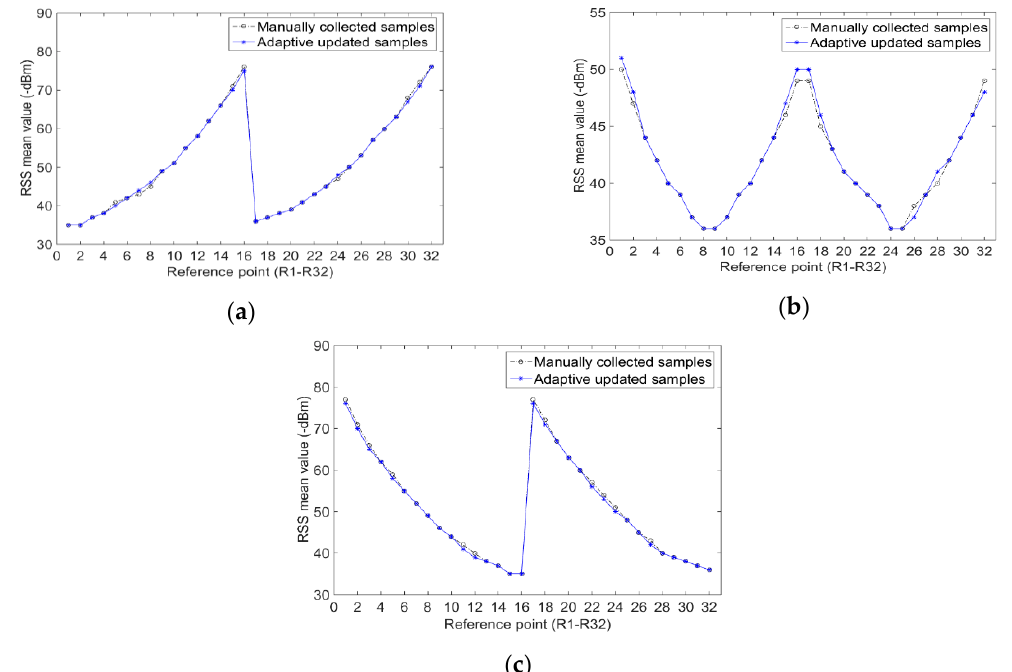
Figure 15. Of adaptive updated results of the radio fingerprint samples: ( a ) mean value of AP 1 ; ( b ) mean value of AP 2 ; ( c ) mean value of AP 3